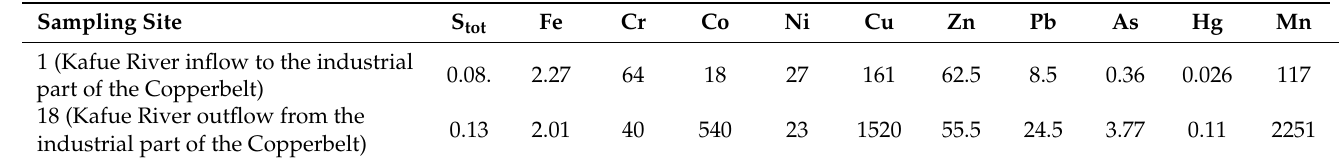
Table 3. Concentration of Stot, Fe, and selected trace elements in stream sediments at the inflow of Kafue River (Sampling site 1, Figure 12) and the outflow from the industrial part of the Zambian Copperbelt (Sampling site 16, Figure 12). Concentrations of Stot and Fe in wt.%, concentration of trace elements in mg/kg. Modified after Kˇr í bek and Nyambe